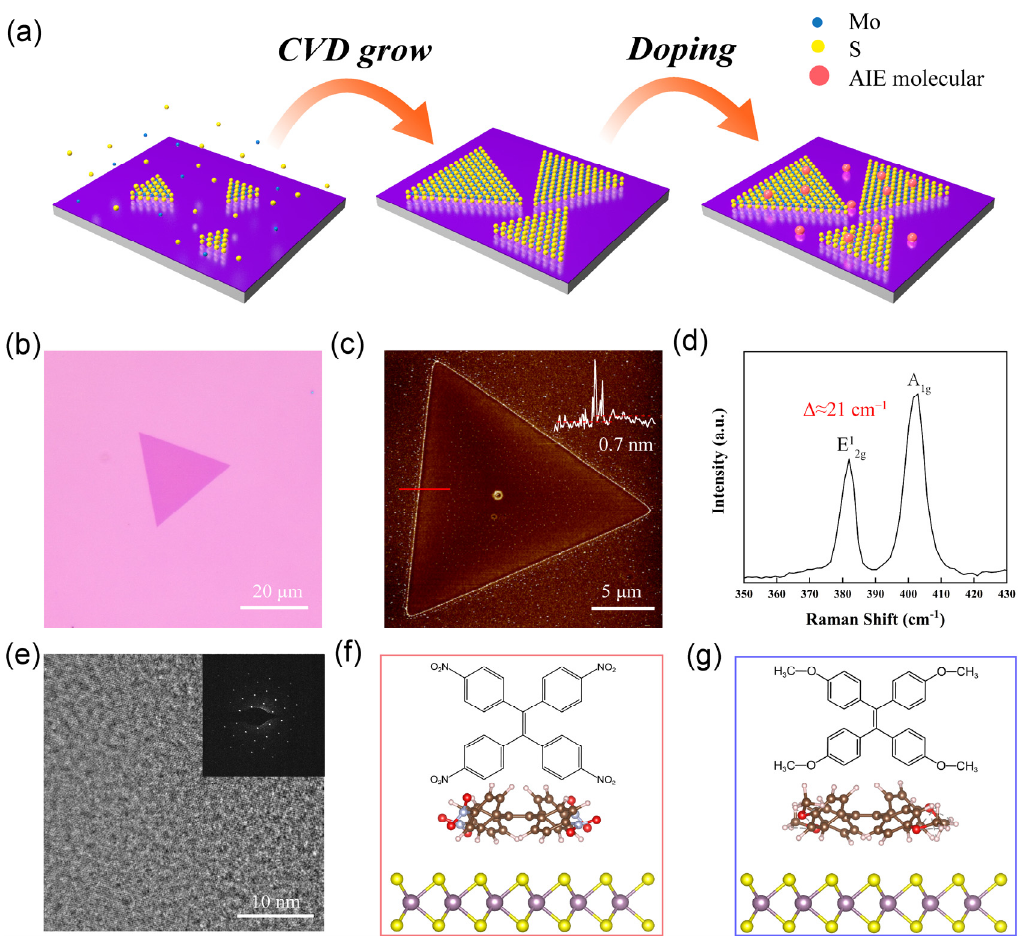
Figure 1. ( a ) Schematic diagram of synthesized monolayer MoS 2 and doping. The monolayer of MoS 2 is grown by the CVD method, and then the grown MoS 2 is immersed in the AIE molecules solution for doping. ( b ) Optical microscope image of MoS 2 . ( c ) AFM image of MoS 2 . ( d ) Raman spectra of MoS 2 . ( e ) TEM image of MoS 2 . The inset is SAED patterns. ( f ) Structural formula of the TPE-4NO 2 molecule and the atomic structure of a single TPE-4NO 2 molecule attached to a single layer of MoS 2 . ( g ) Structural formula of the TPE-4OCH 3 molecule and the atomic structure of a single TPE-4OCH 3 molecule attached to a single layer of MoS 2